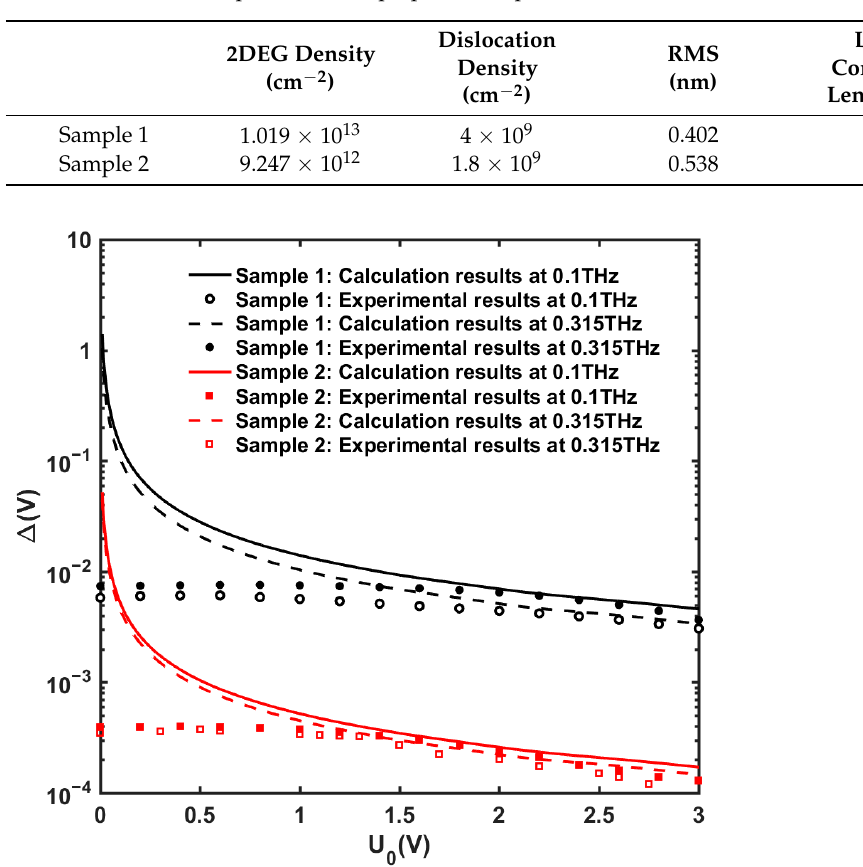
Table 2. Main material parameters of prepared samples.